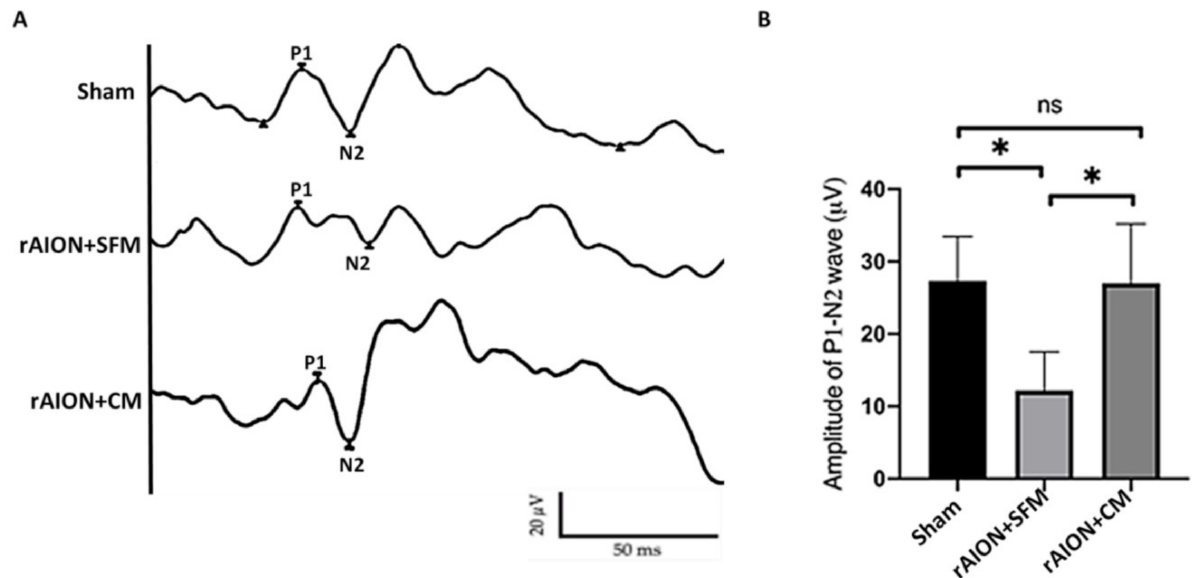
Figure 6. FVEP profiles at day 28 post-rAION (rodent model of anterior ischemic optic neuropathy) induction. ( A ) Represen- tative FVEP wavelet in each group. ( B ) Treatment with CM induced the P1-N2 amplitude by 1.97-fold compared to treatment with SFM (* p < 0.05, n = 12 per group). Data are expressed as mean ± SD. SFM: serum-free medium; CM: conditioned medium. P1, P1 the first positive peak; N2, the second negative peak; ns, not